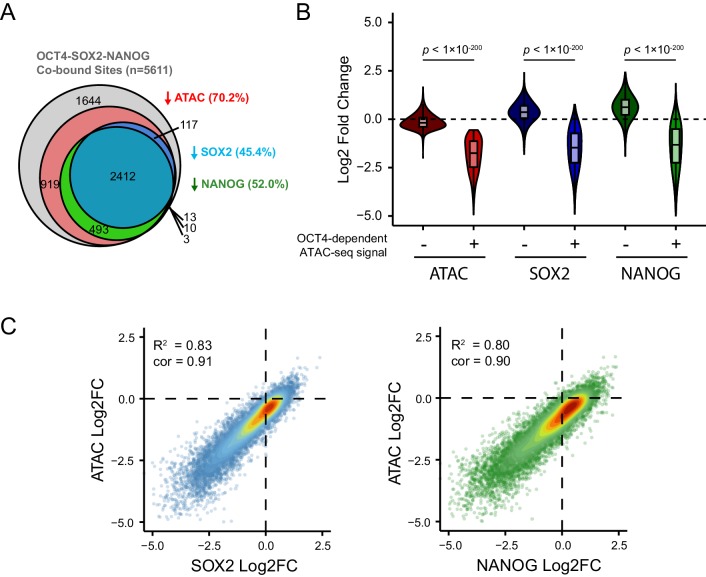
Loss of SOX2 and NANOG is highly correlated with reductions in chromatin accessibility at OCT4-SOX2-NANOG targets.(A) A Venn diagram depicting the relationship between significant reductions in ATAC-seq and SOX2/NANOG ChIP-seq signal at OCT4-SOX2-NANOG co-bound peaks (n = 5611). % denotes percentage of OCT4-SOX2-NANOG peaks with significant reduction for each factor or assay. (B) A violin plot comparing the log2 fold change in SOX2 and NANOG ChIP-seq signal after depletion of OCT4 between OCT4-SOX2-NANOG co-bound peaks with OCT4-dependent (n = 3941) or OCT4-independent (n = 1644) chromatin accessibility. (C) Scatterplots depicting log2 fold changes of SOX2 or NANOG against the log2 fold change in chromatin accessibility (measured by ATAC-seq) at OCT4-SOX2-NANOG co-bound targets (n = 5611) in OCT4cond ESCs after 24 hr DOX treatment.